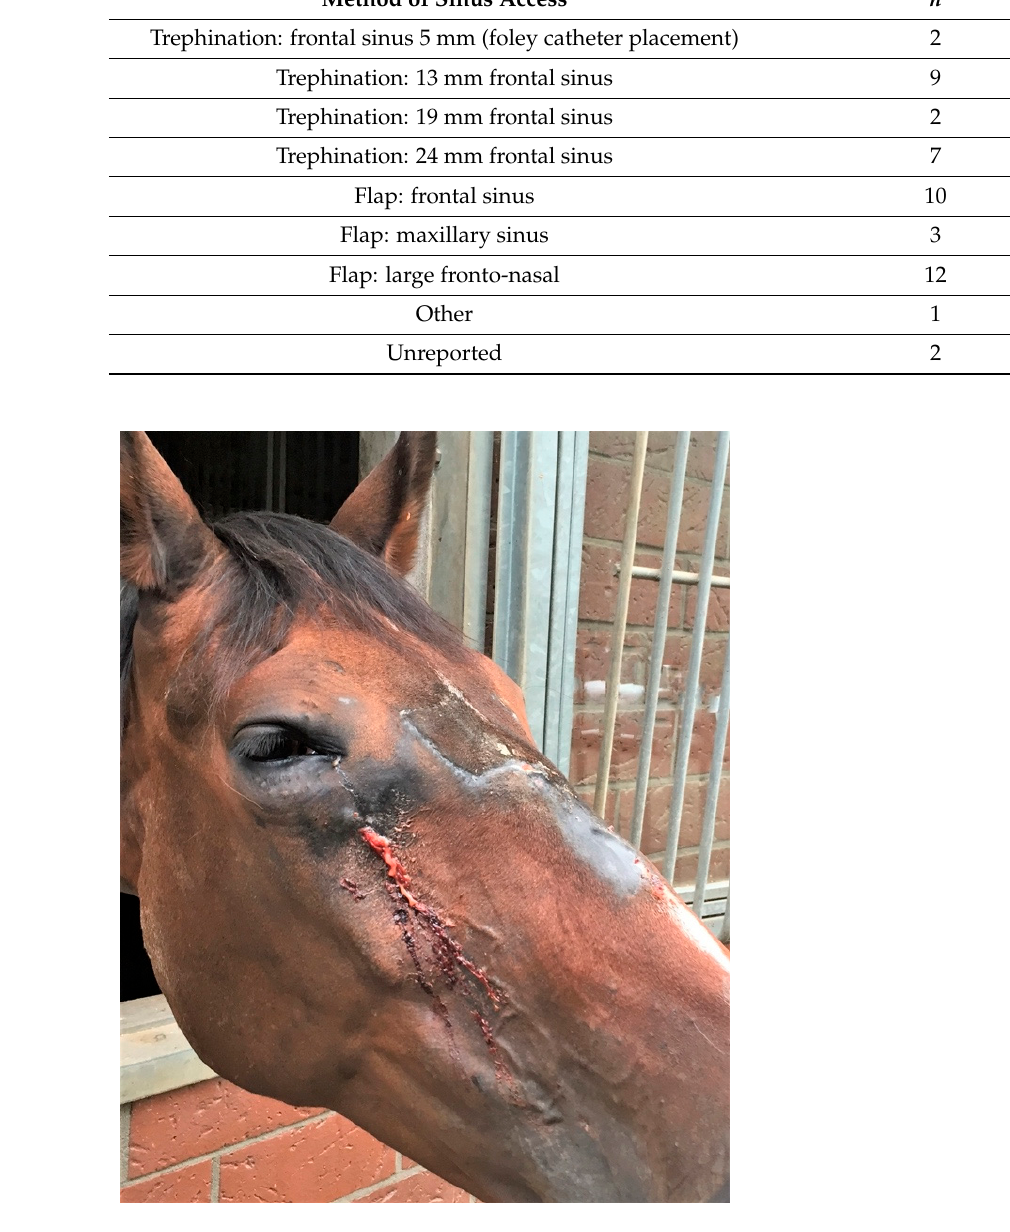
Figure 3. Mare after bone flap surgery with secondary suture exostosis leading to bacterial infection and abscess formation on the nasal bridge and under the right eye.